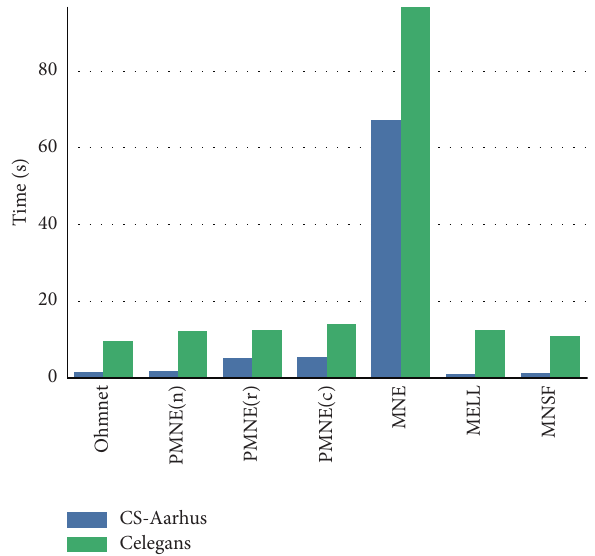
Figure 11: The run time of different verification algorithms in Celegans and CS-Aarhus